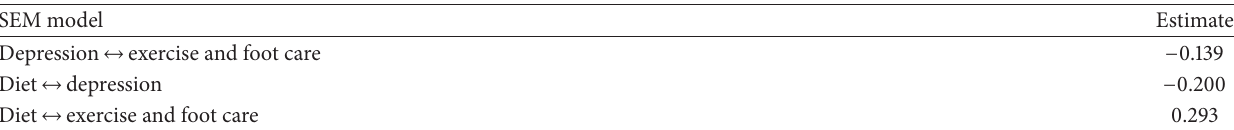
Table 4: Estimated correlations in the SEM.